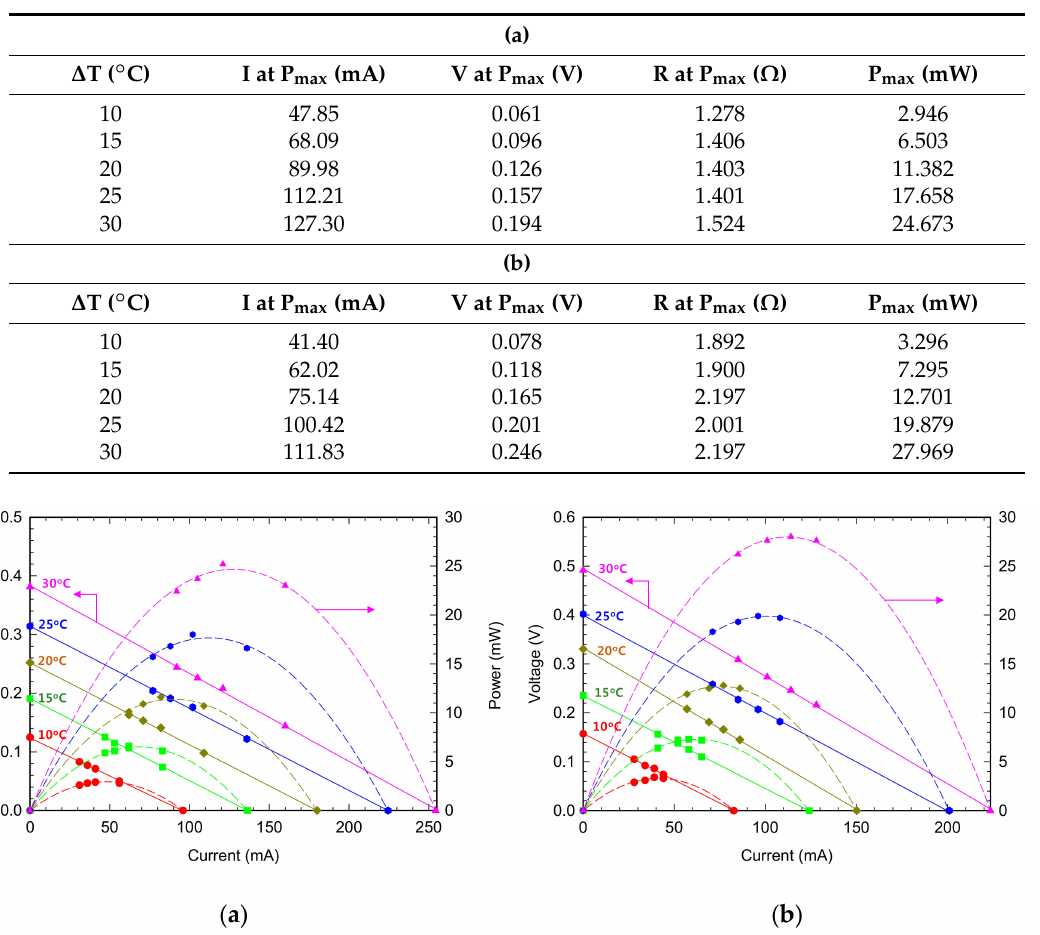
Figure 8. I–V characteristics of ( a ) 128A1030 (Peltron) and ( b ) TK-1-3-S (HTRD) TEMs for different temperature